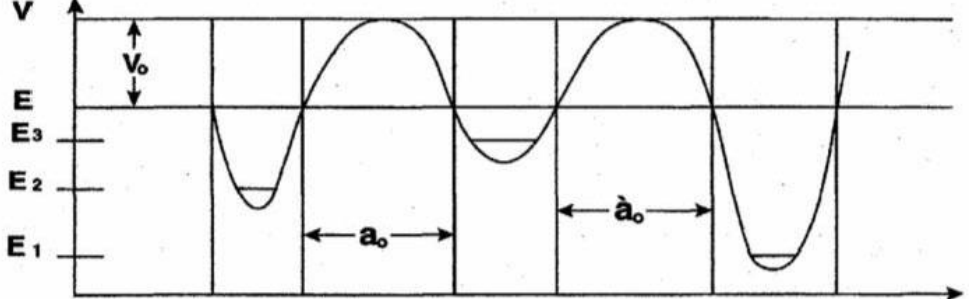
Figure A-1. Qualitative energy surface for a composite DNA proton system occupying the metastable, hybrid and ground